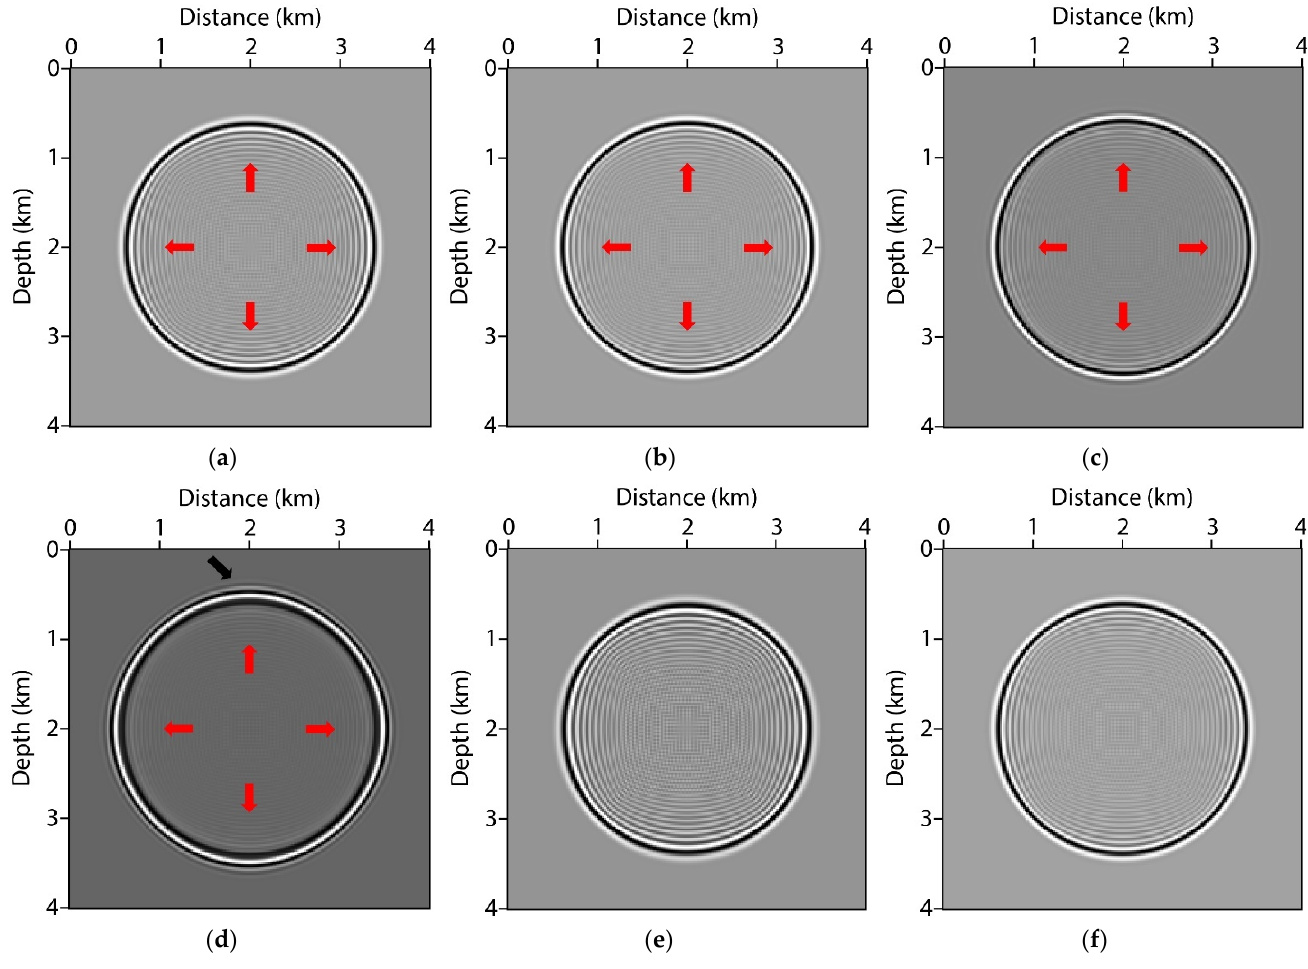
Figure 4. Snapshots of the homogeneous model at 0.5 s. They are simulated by: ( a ) CFD4 scheme, ( b ) OCFD4 scheme (0.5 π ), ( c ) OCFD4 scheme (0.75 π ), ( d ) OCFD4 scheme ( π ), ( e ) fourth-order central FD scheme, and ( f ) sixth-order central FD scheme, respectively. The red arrows indicate the spatial dispersion and the black arrow indicates the temporal dispersion.